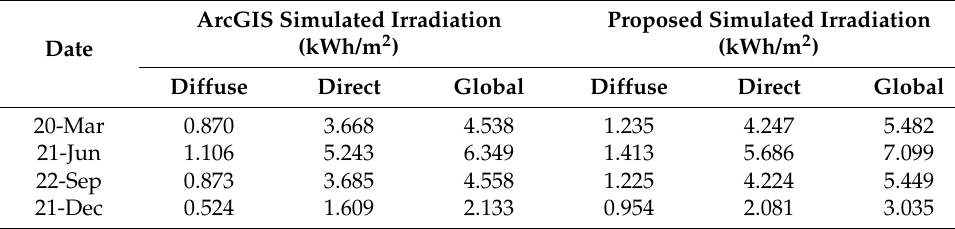
Table 3. Irradiation result comparison within a day.